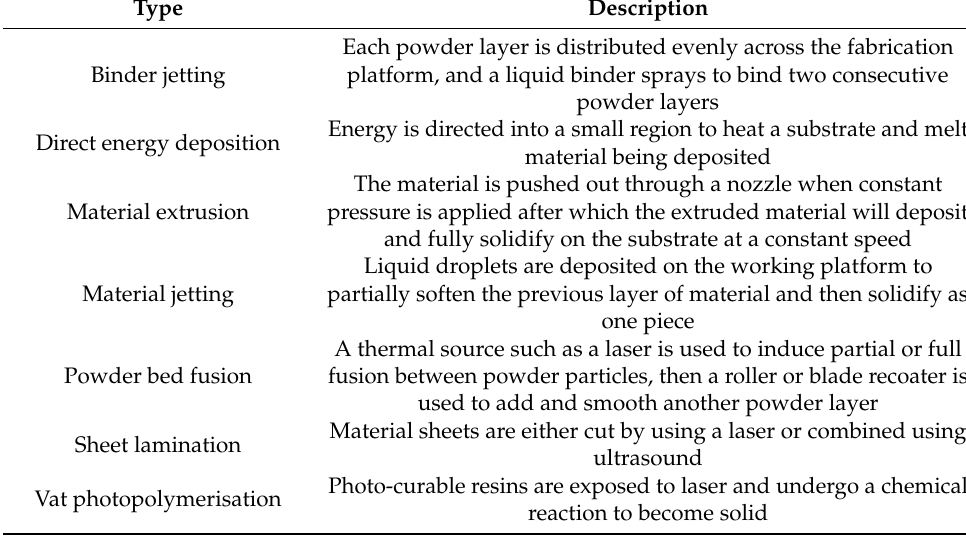
Figure 2. Illustrating the workflow of 3D printing. Adapted from [64]. Table 1. Description of main 3D printing processes.